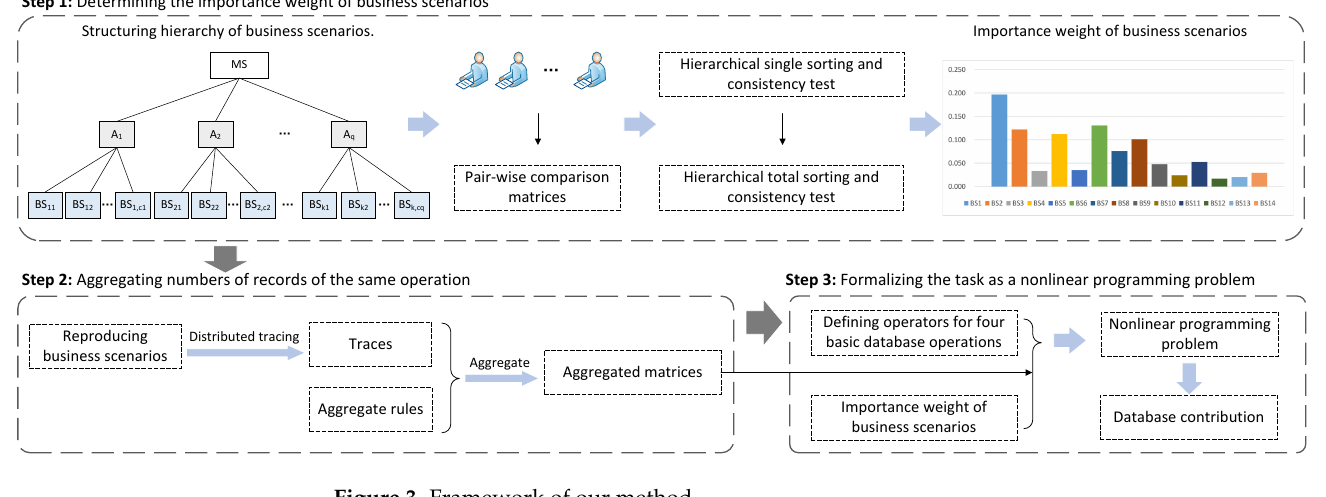
Figure 3. Framework of our